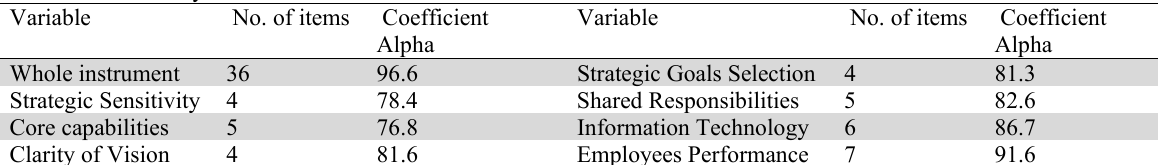
Instrument Reliability